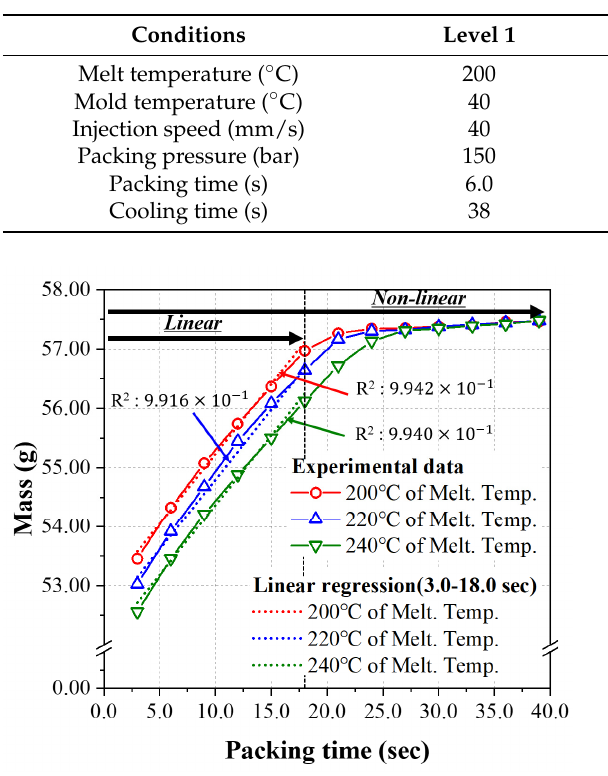
Table 4. Process conditions and levels for the experiment.